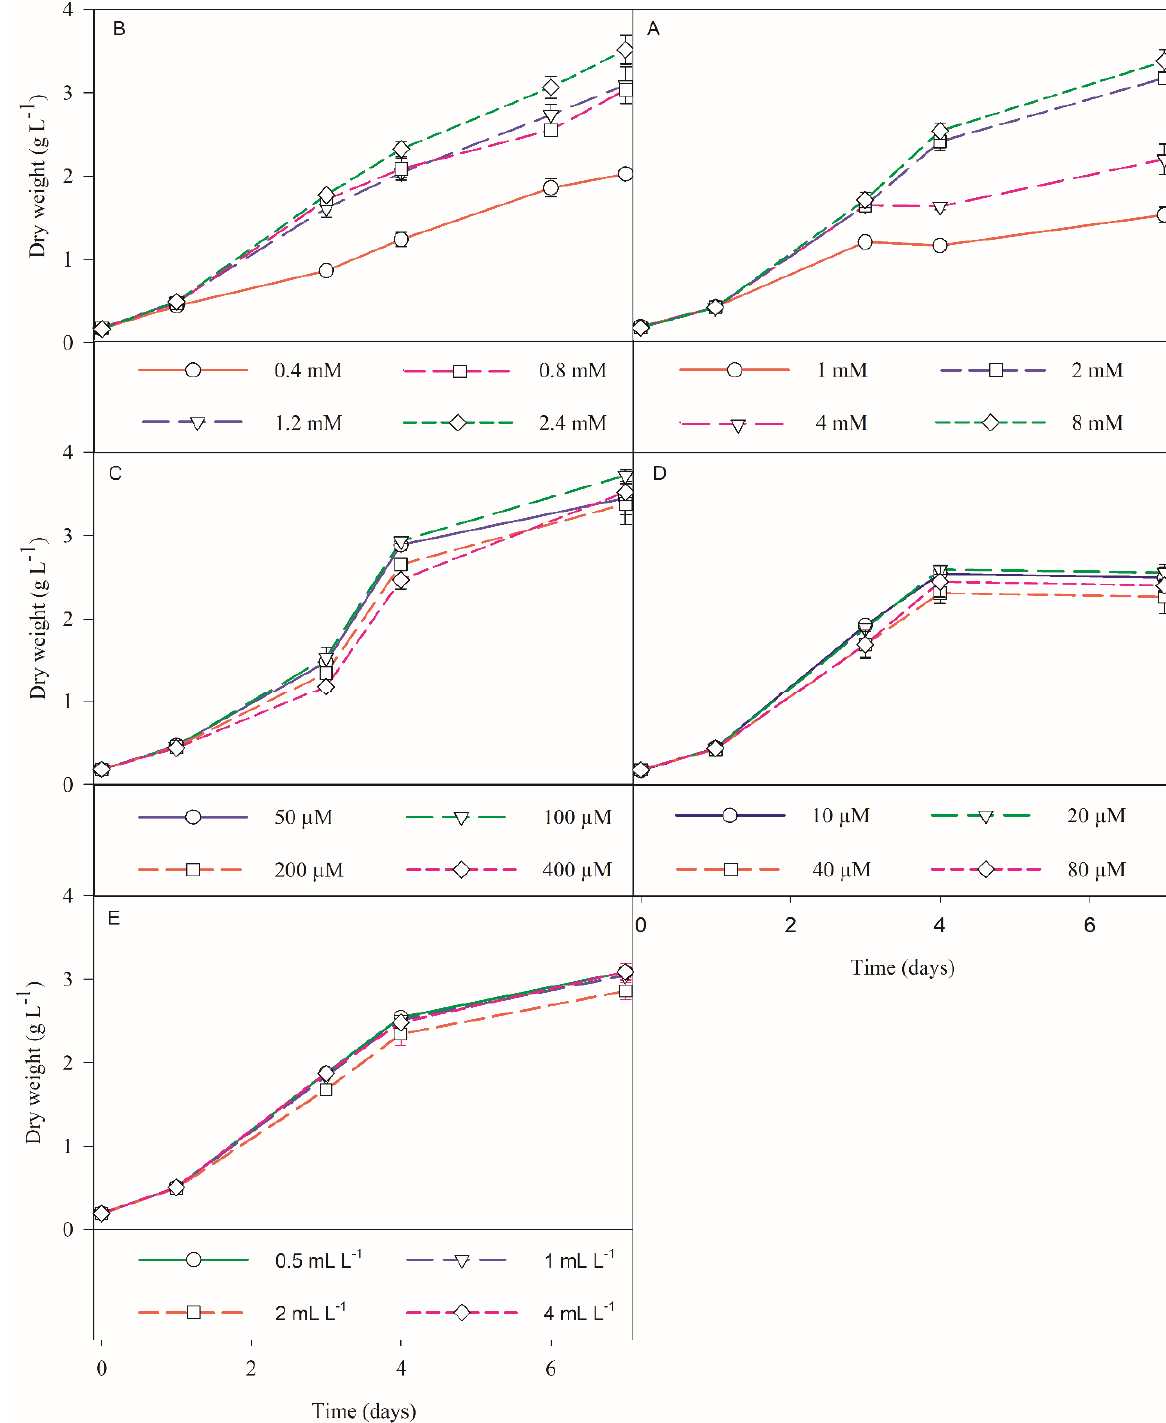
Figure 2. S. costatum growth performance in terms of biomass dry weight (g L − 1 ) that was obtained in 1-L bubble column PBRs in order to optimise the supply of a specific nutrient ( A ) silicate, ( B ) nitrate, ( C ) phosphate, and ( D ) iron or ( E ) micronutrient concentrations ( n = 3). The values are represented as the mean ± standard deviation.